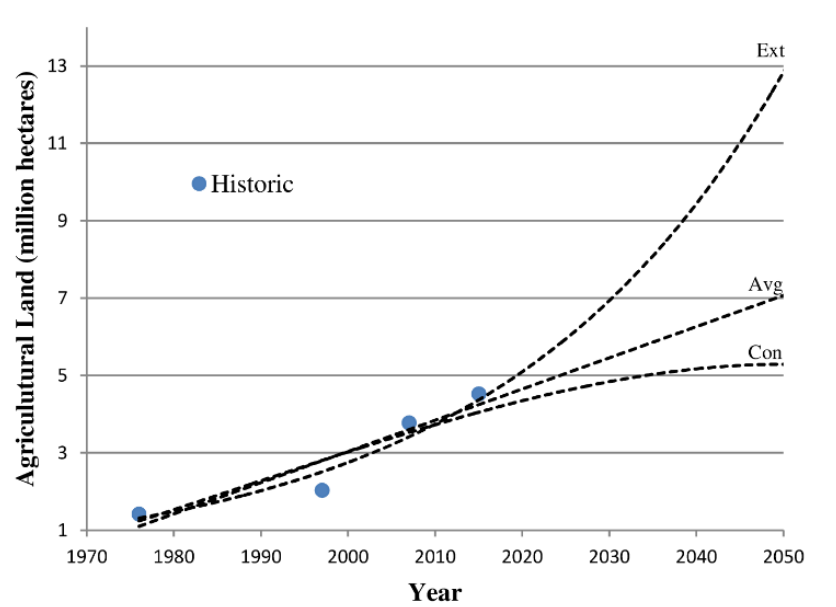
Figure 5. Agricultural growth projections with historic